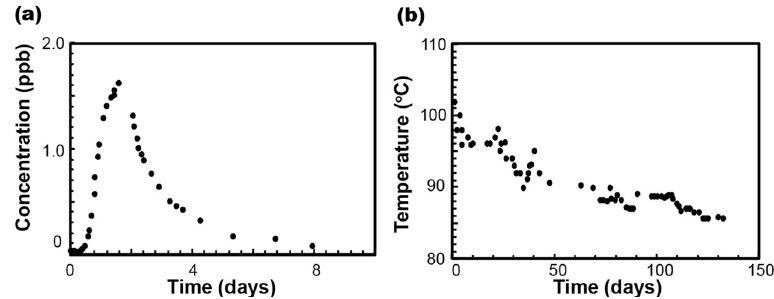
Figure 8. Field data from Balcova geothermal field. ( a ) tracer response and ( b ) temperature decline curves [24].